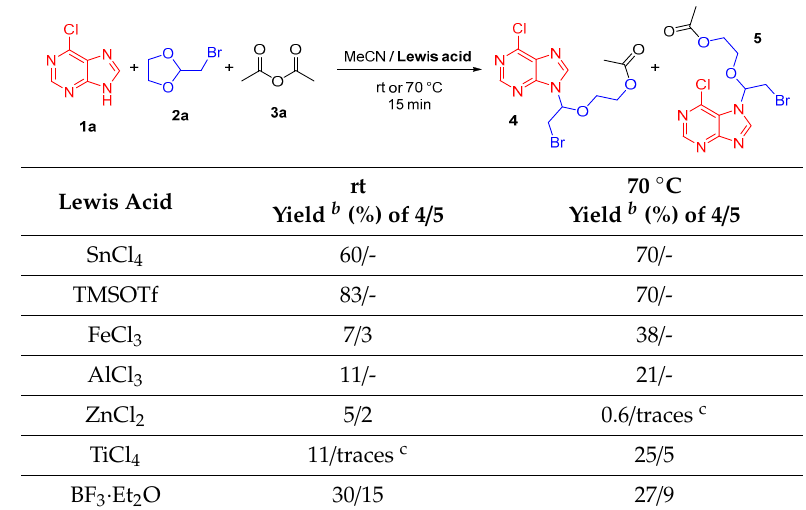
Table 1. Preparation of acyclonucleoside 4 by multi-component reaction—Lewis acid optimization a .